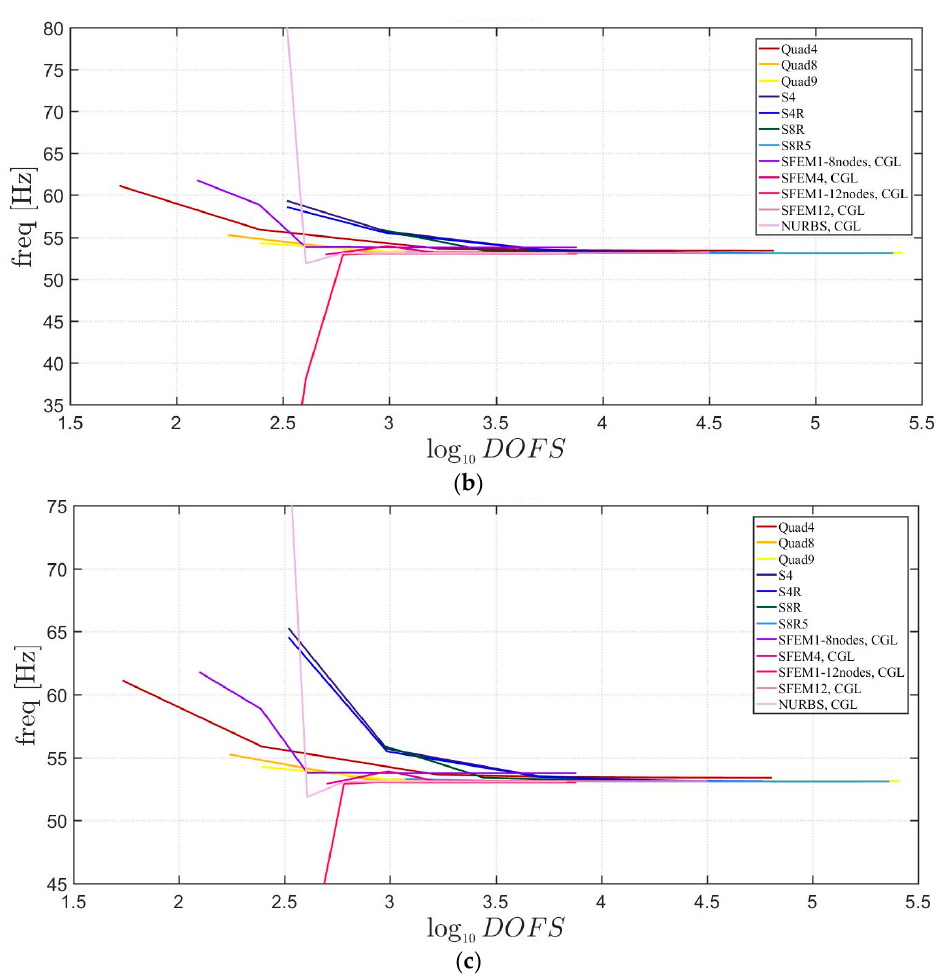
Figure 5. First three natural frequencies of an isotropic circular plate: ( a ) First frequency; ( b ) Second frequency; ( c ) Third frequency.